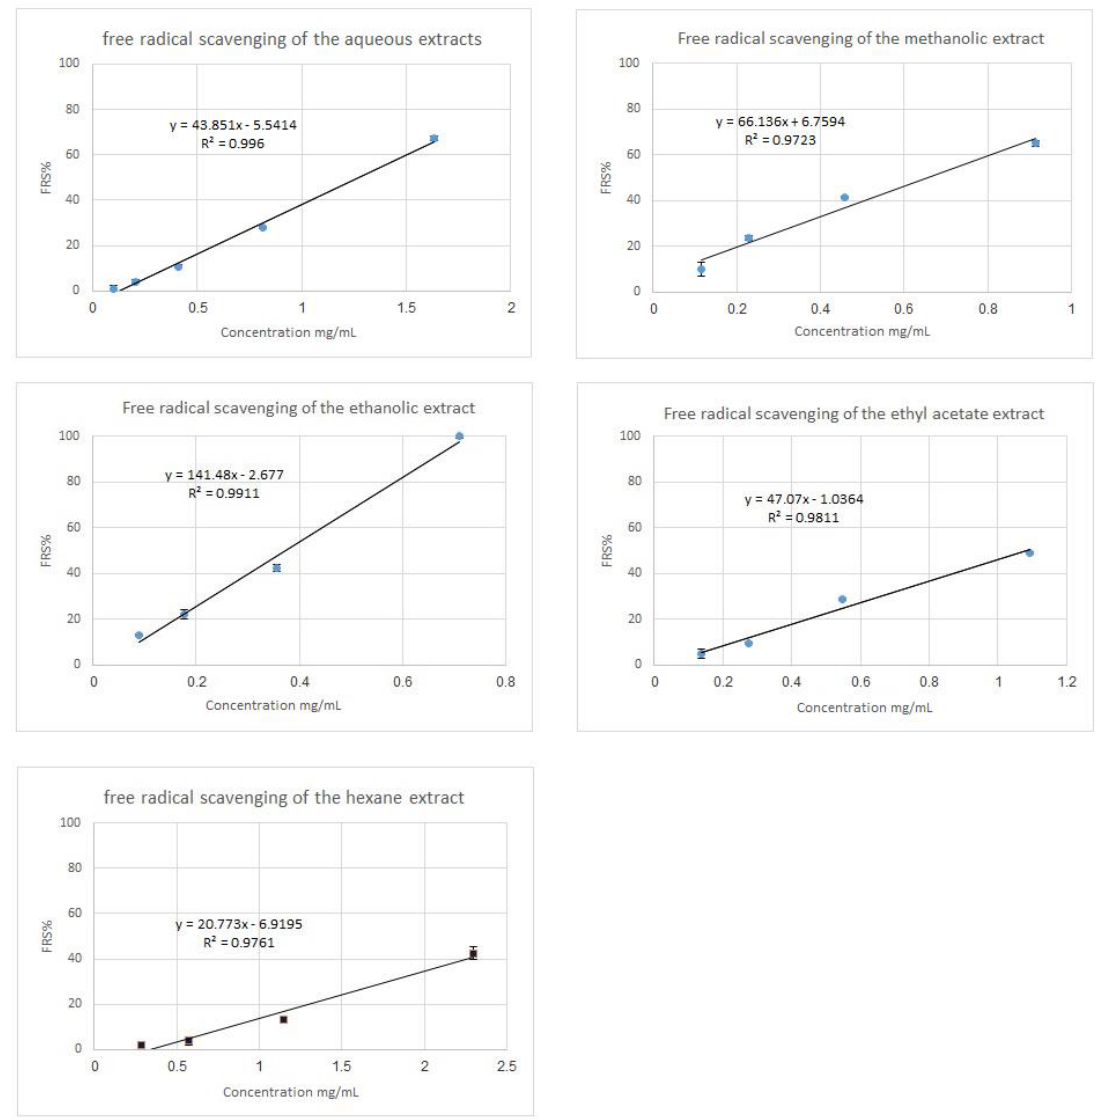
Figure 3. Free radical scavenging of all S. maculatus five extracts. At each concentration, the experiment was run four times. The data shown are the means ± the standard error of the means from the four experiments.